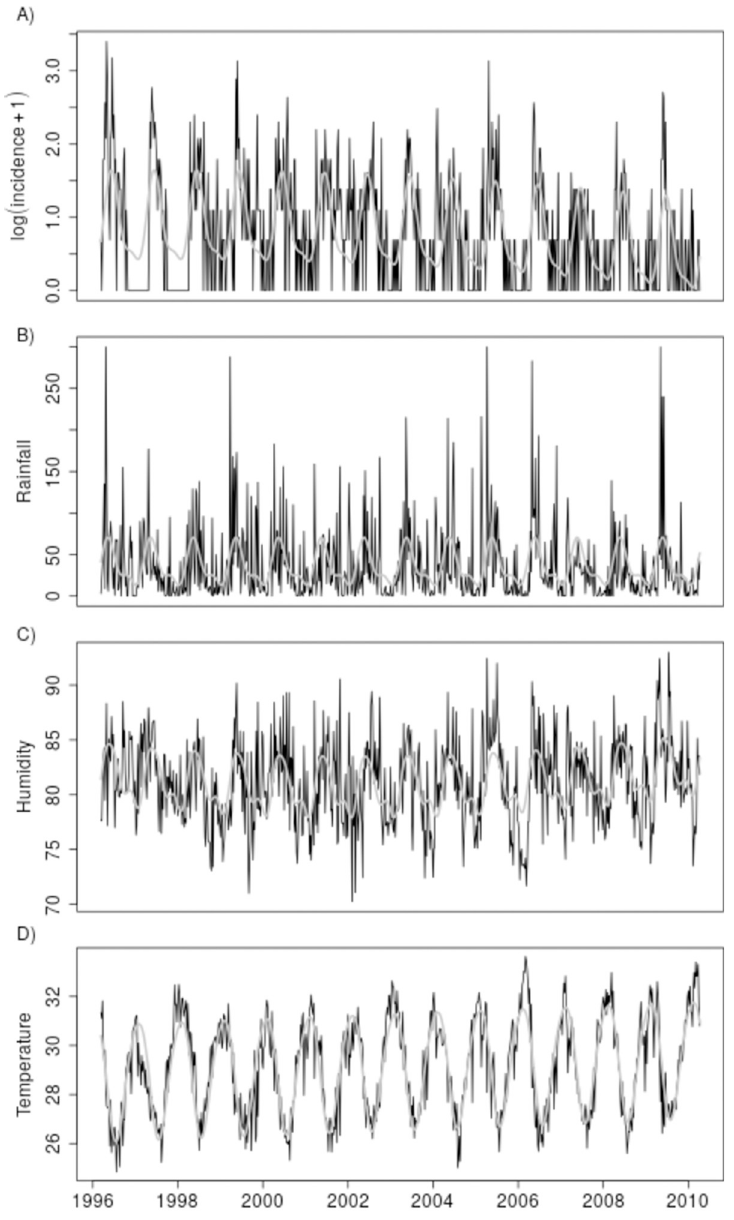
Fig 1. Observed time series (black) and fitted trends (grey) for transformed weekly laboratory confirmed leptospirosis incidence series (panel A) and meteorological time series: weekly accumulated rainfall in mm (panel B); weekly average of mean daily relative humidity in percent (panel C); and weekly average of mean daily maximum temperature in ˚C (panel D), Salvador, Brazil,